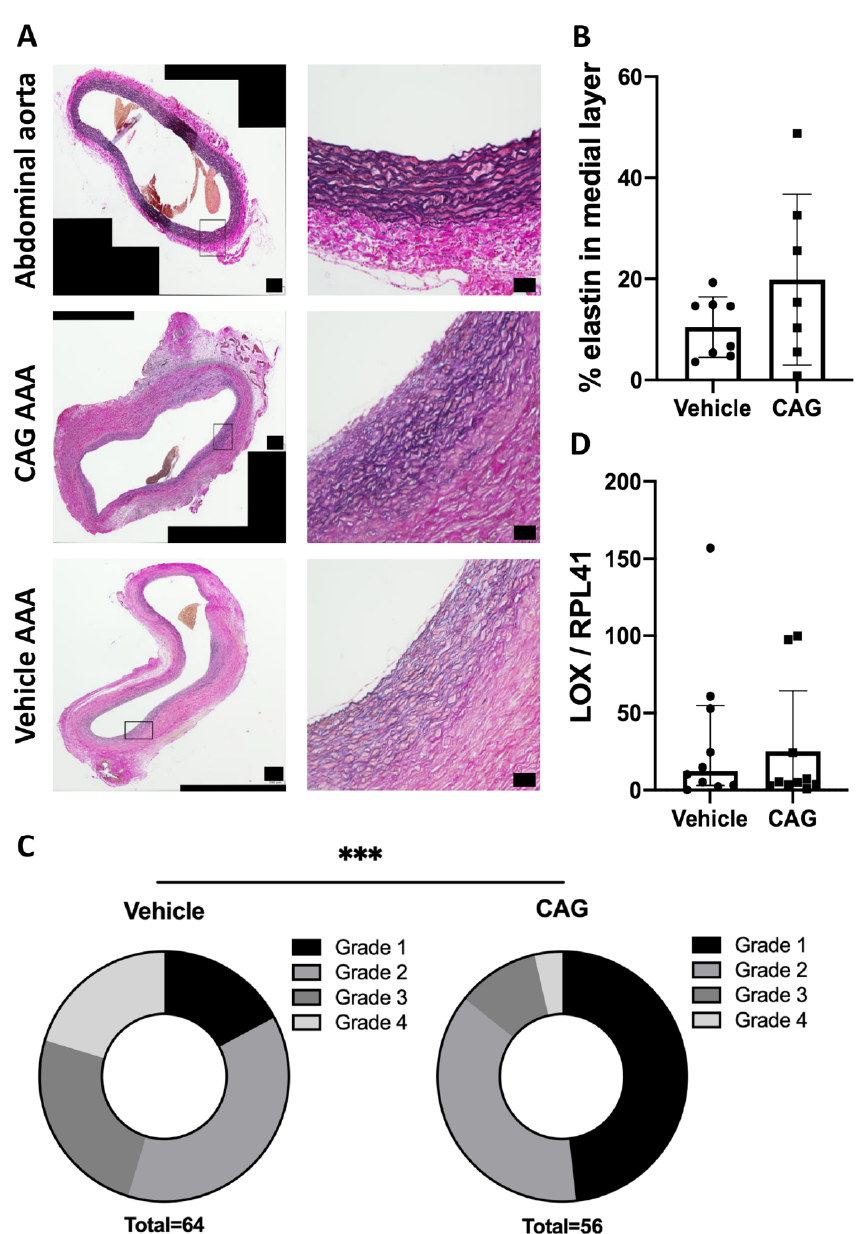
Figure 3. Elastin assessment in abdominal aortic aneurysms (AAA) ( A ) Representative micrographs of Miller’s elastin stain (black) from abdominal aorta, vehicle AAA and CAG AAA at day 28 (en- largements correspond to black square on the left image). Scale bar (black box) in micrographs to the left: 100 µm and micrographs to the right: 50 µm ( B ) Percentage of elastin in medial layer in vehicle and CAG group AAA at day 28 (n = 8/7). ( C ) Scoring of aneurysmal wall elastin disruption in vehicle and CAG group 1–4, 4 being severe wall disruption and 1 minimal wall disruption (n = 8/7; p = 0.0003). ( D ) Elastin related mRNA coding for LOX gene (n = 10/10) normalized to RPL41 mRNA levels. Values are median ± inter quartile range. *** Indicates p < 0.001 .